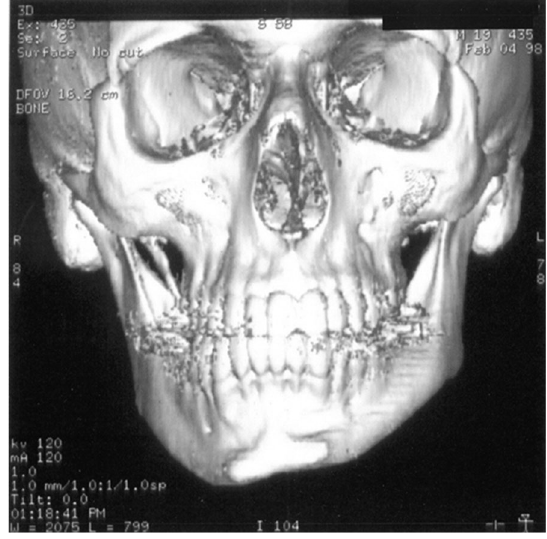
Fig. 1 Computed tomography (CT) with 3D reconstruction. The facial asymmetry is due to the underdevelopment of the left side of the mandible